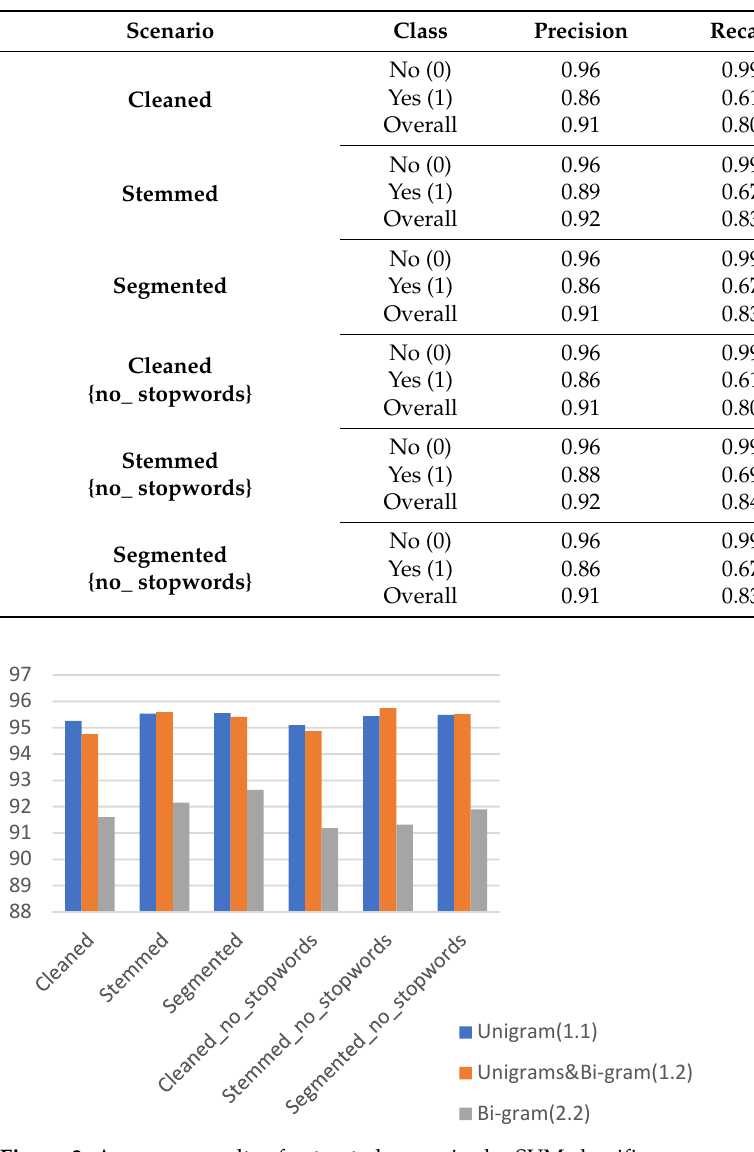
Figure 3. Accuracy results of extracted scenarios by SVM classifier.